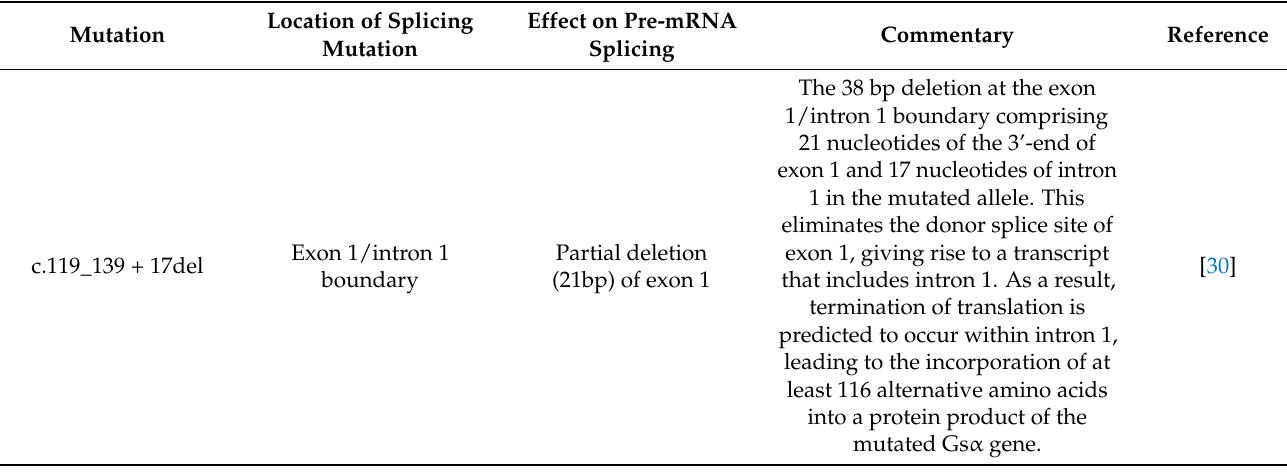
Table 4. Examples of different GNAS splicing mutations in